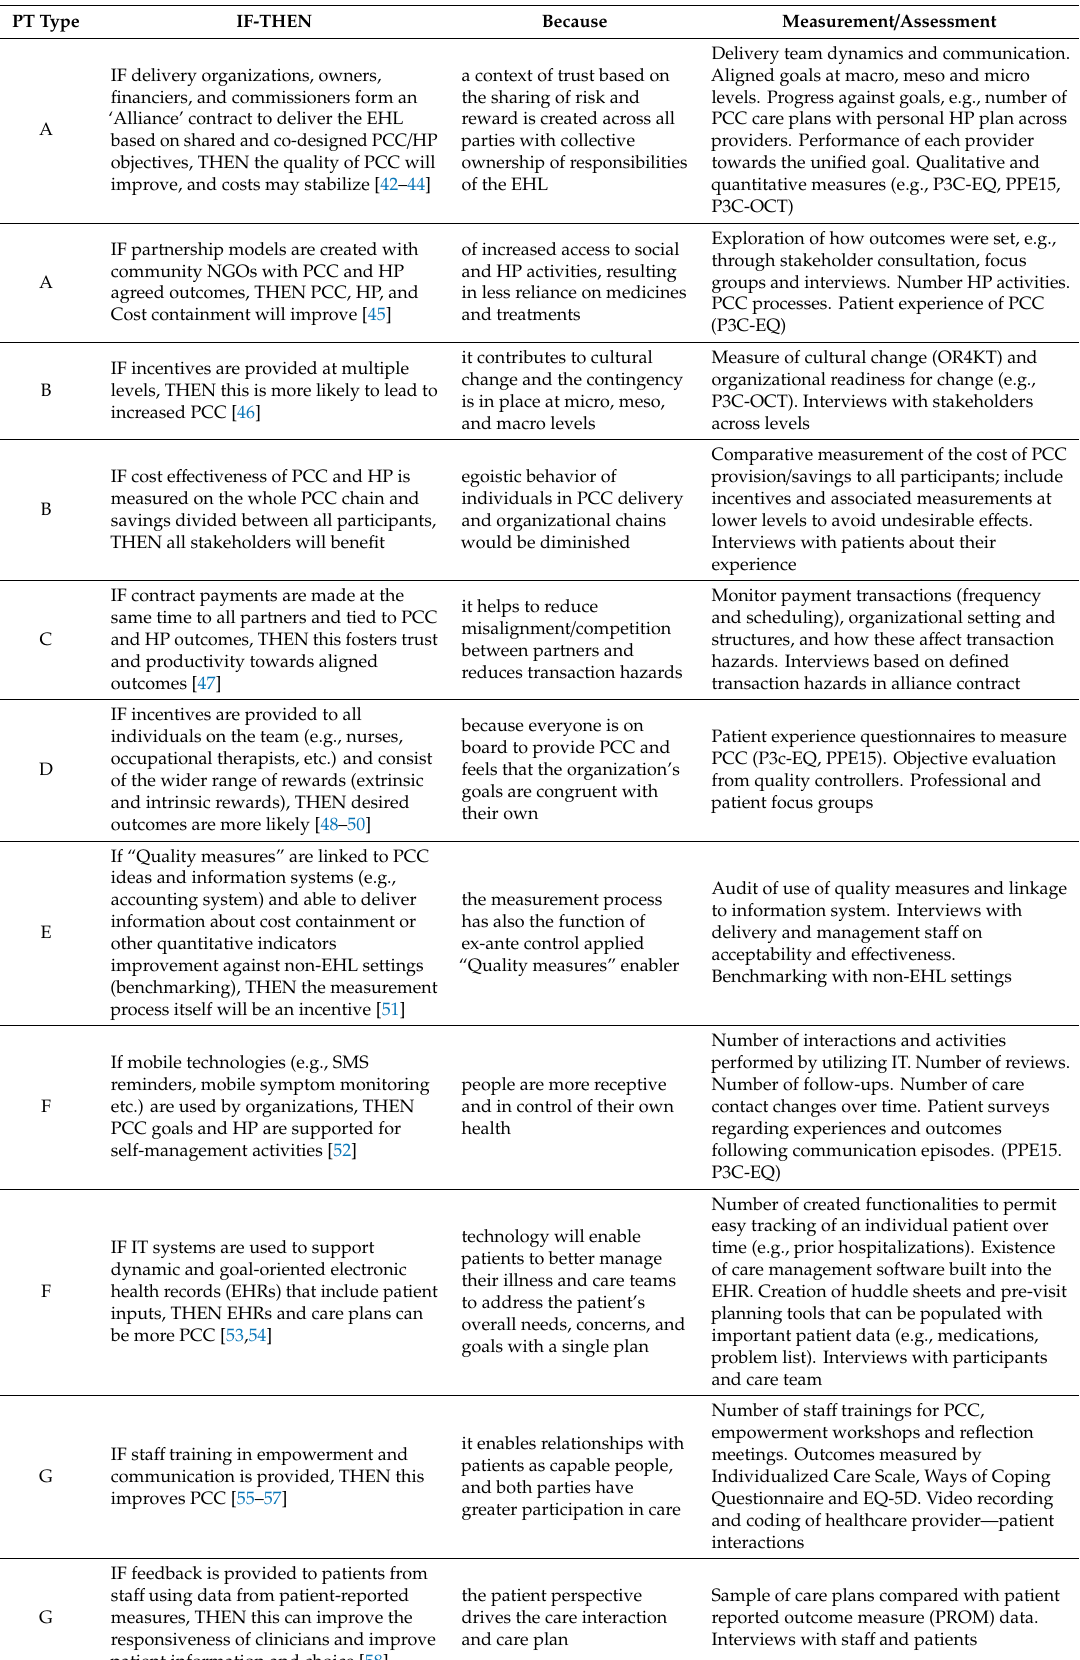
Table 1. Program theories, if-then-because statements, and measurement / assessment examples. PT